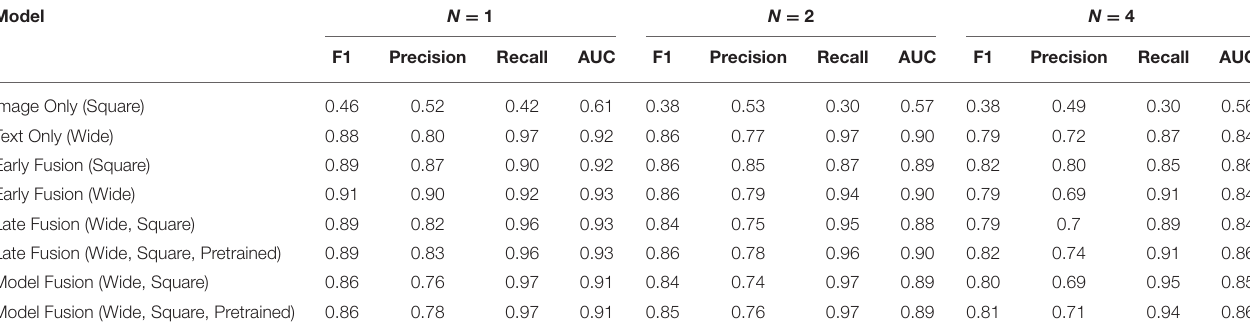
Late Fusion (Wide, Square, Pretrained) Model Fusion (Wide, Square) Model Fusion (Wide, Square, Pretrained) 0.79